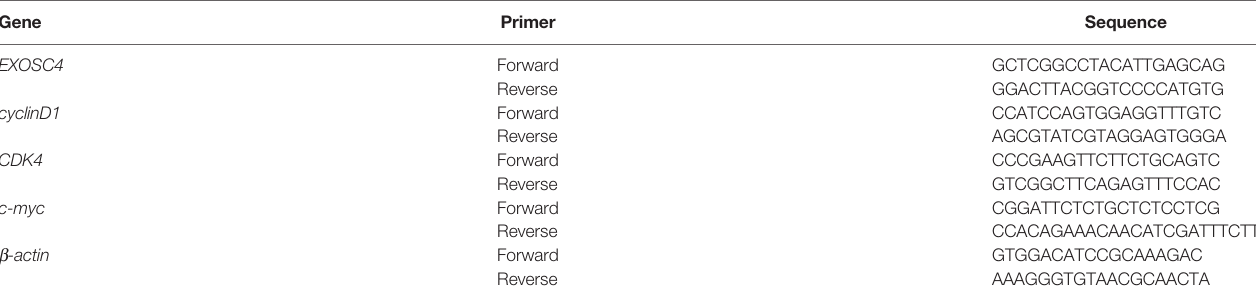
TABLE 1 | Primers for